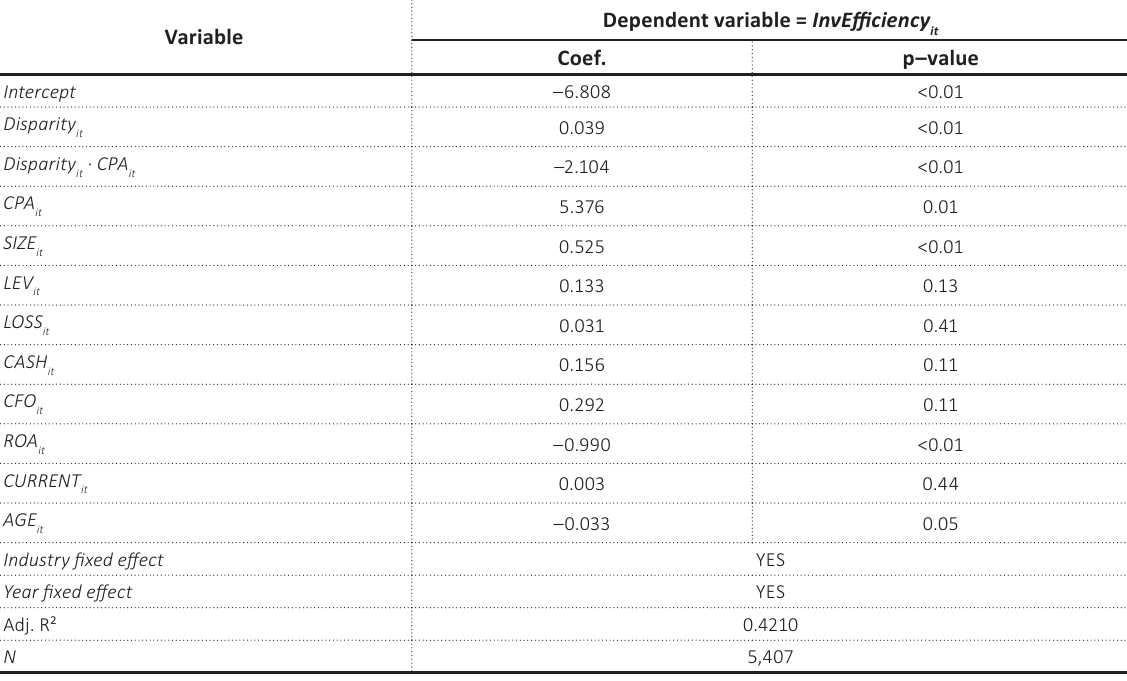
Table 4 (cont.). Role of human resource investment in IC on the association between pay disparity and investment inefficiency